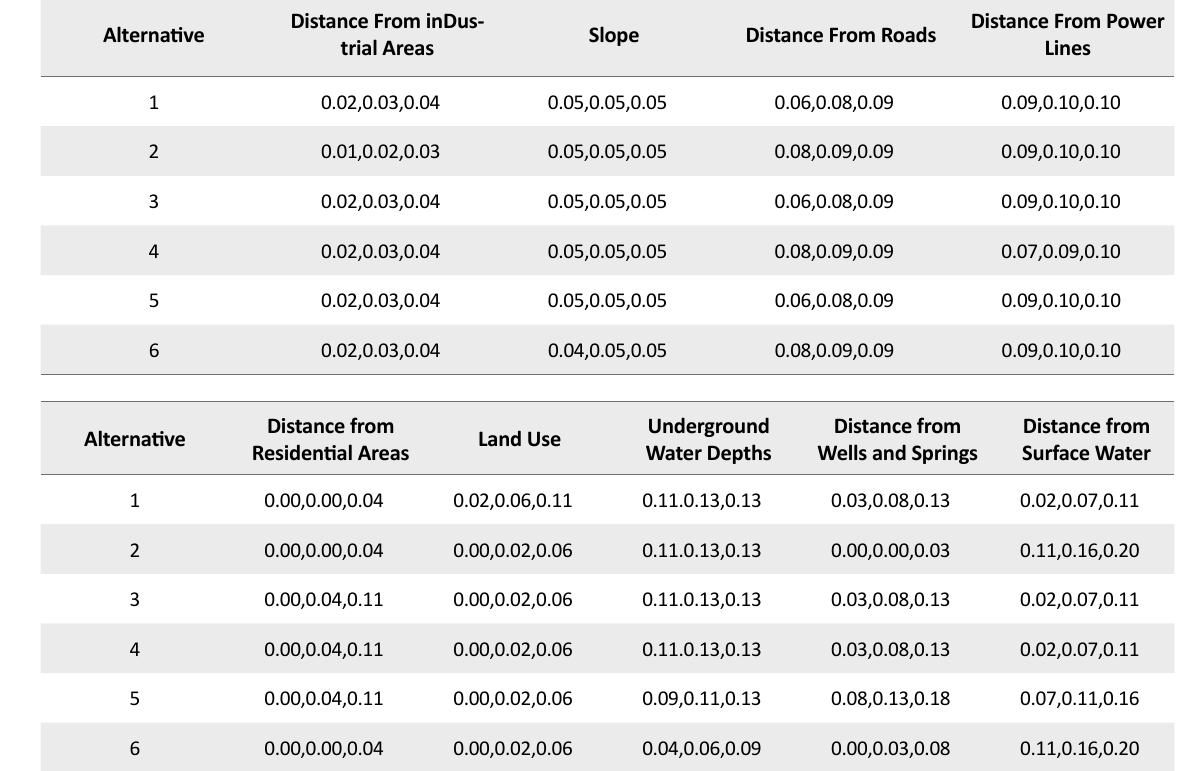
Distance From Power Lines